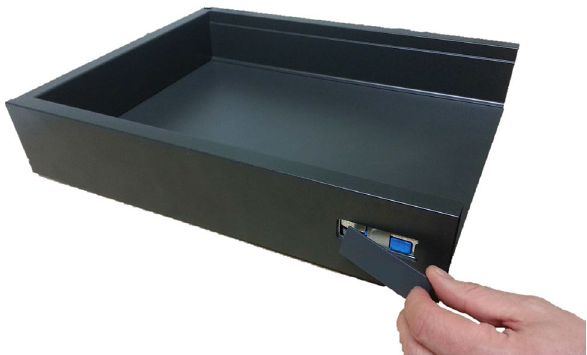
Figure 2. Drawer system mockup.